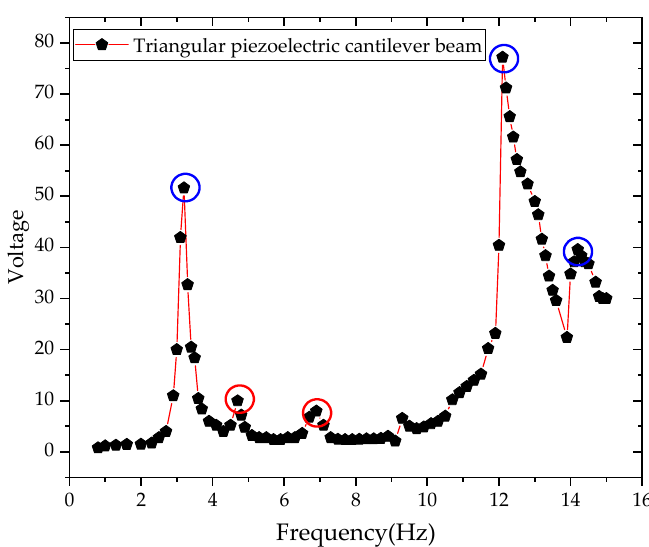
Figure 21. The relation between voltage and frequency of triangular PCB.